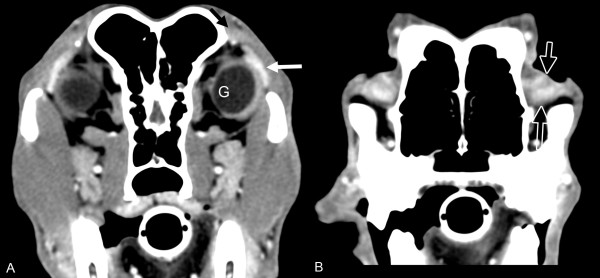
Transverse contrast-enhanced CT images of the lacrimal glands. Image markers A-B denote the right side of the image. (A) The lacrimal gland (white arrow) and (B) accessory lacrimal gland of the third eyelid (open arrows) are markedly contrast-enhancing structures on postcontrast 1.25 mm CT images.